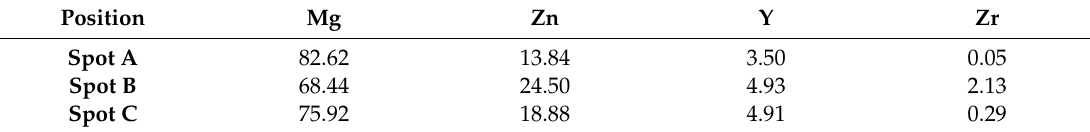
Figure 7. ( a ) SEM microstructure and EDS analysis of Mg-1YL: ( b ) Spot A, ( c ) Spot B, ( d ) Spot C. Table 5. Atom ratios (at%) for different elements of each spot in Figure 7a.